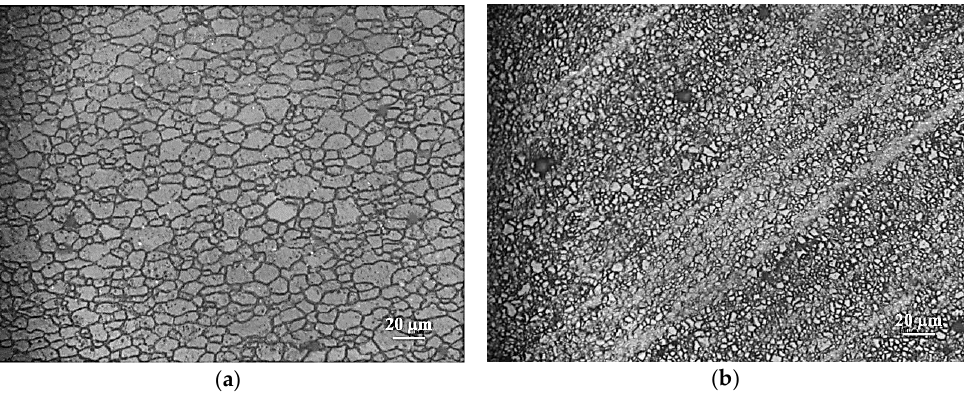
Figure 7. Microstructures of AZ31-2Ca-1.5NAl composite deformed at ( a ) 400 ◦ C/0.0003 s − 1 (Domain 2) and ( b ) 300 ◦ C/10 s − 1 (Domain 3).